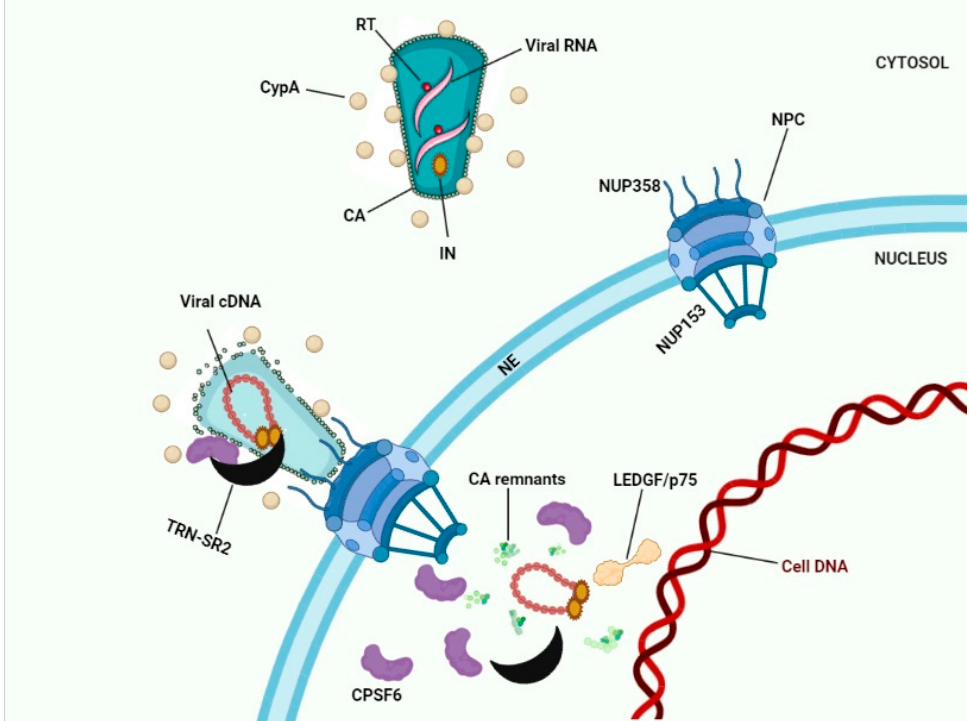
Figure 3. HIV-1 nuclear import. Interaction between Nup358 and viral CA results in docking of HIV-1 cones to the NE. Depending on the model chosen (see Figure 2) capsid uncoating occurs in the cytoplasm, at the NE, or in the nucleus. Interaction between Nup153 and CA results in docking to the nuclear basket of the NPC. CPSF6 bound to CA proteins may recruit TRN-SR2 to the PICs. After capsid uncoating the triple complex of transportin-SR2/HIV-1 IN/CPSF6 may subsequently translocate the viral integration complex into the nucleus. Binding of nuclear CPSF6 molecules to CA remnants may release these remnants into the nucleoplasm.